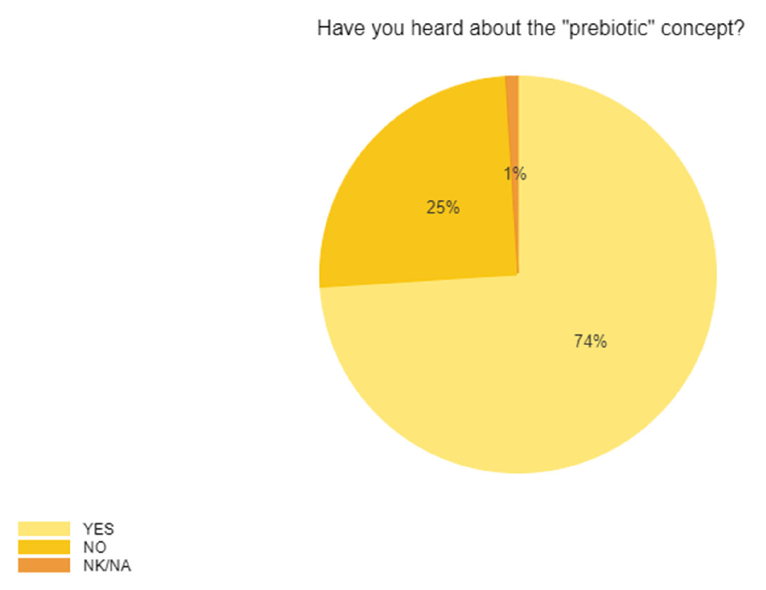
Figure 5. The awareness of the prebiotic concept.